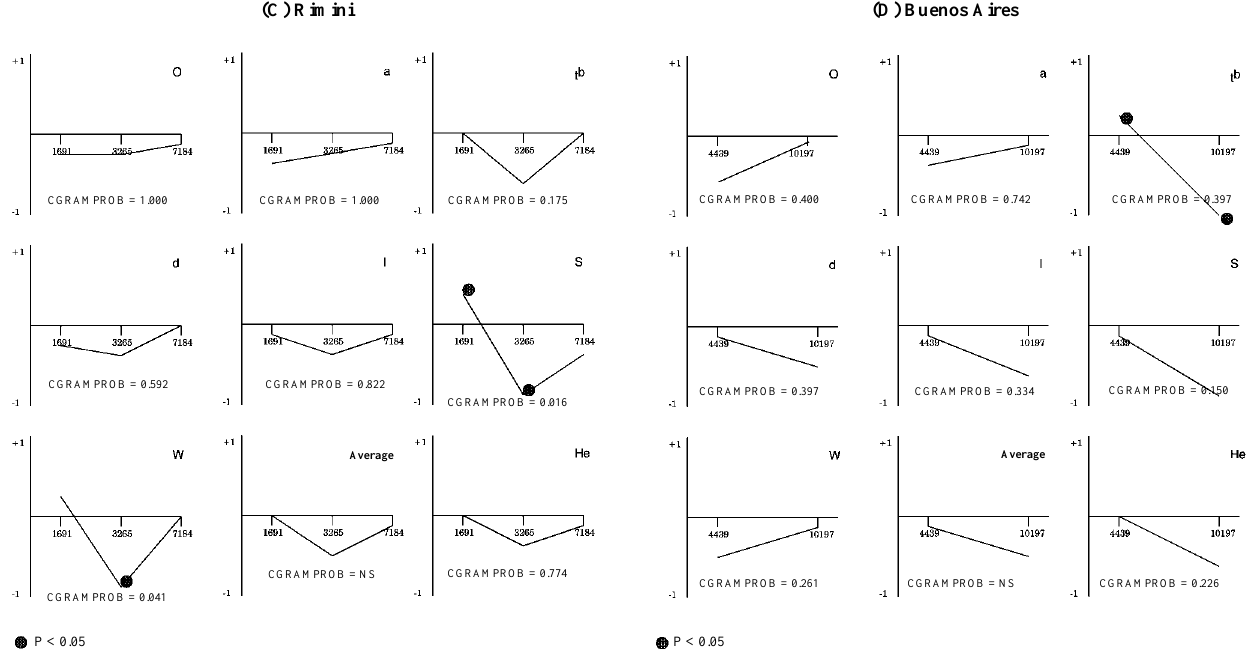
Figure 1 - Correlograms of the seven alleles analyzed (O = orange, a = non-agouti, t b = blotched tabby, d = dilution, l = long hair, S = white spotting and W = dominant white) and of He (expected average heterozygosity). These correlograms were obtained with Moran´s I index at subpopulation level with 3 distance classes (DC). (A) Barcelona; (B) Palma Majorca; (C) Rimini; (D) Buenos Aires. CGRAMPROB = Overall correlogram probability. NS =